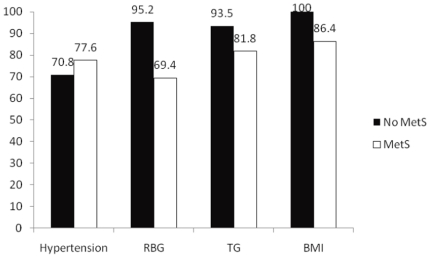
Five-years survival related to MetS by different components of MetS.(* p<0.05). RBG = Random Blood Glucose, TG = Triglyceride, BMI = Boby Mass Index.